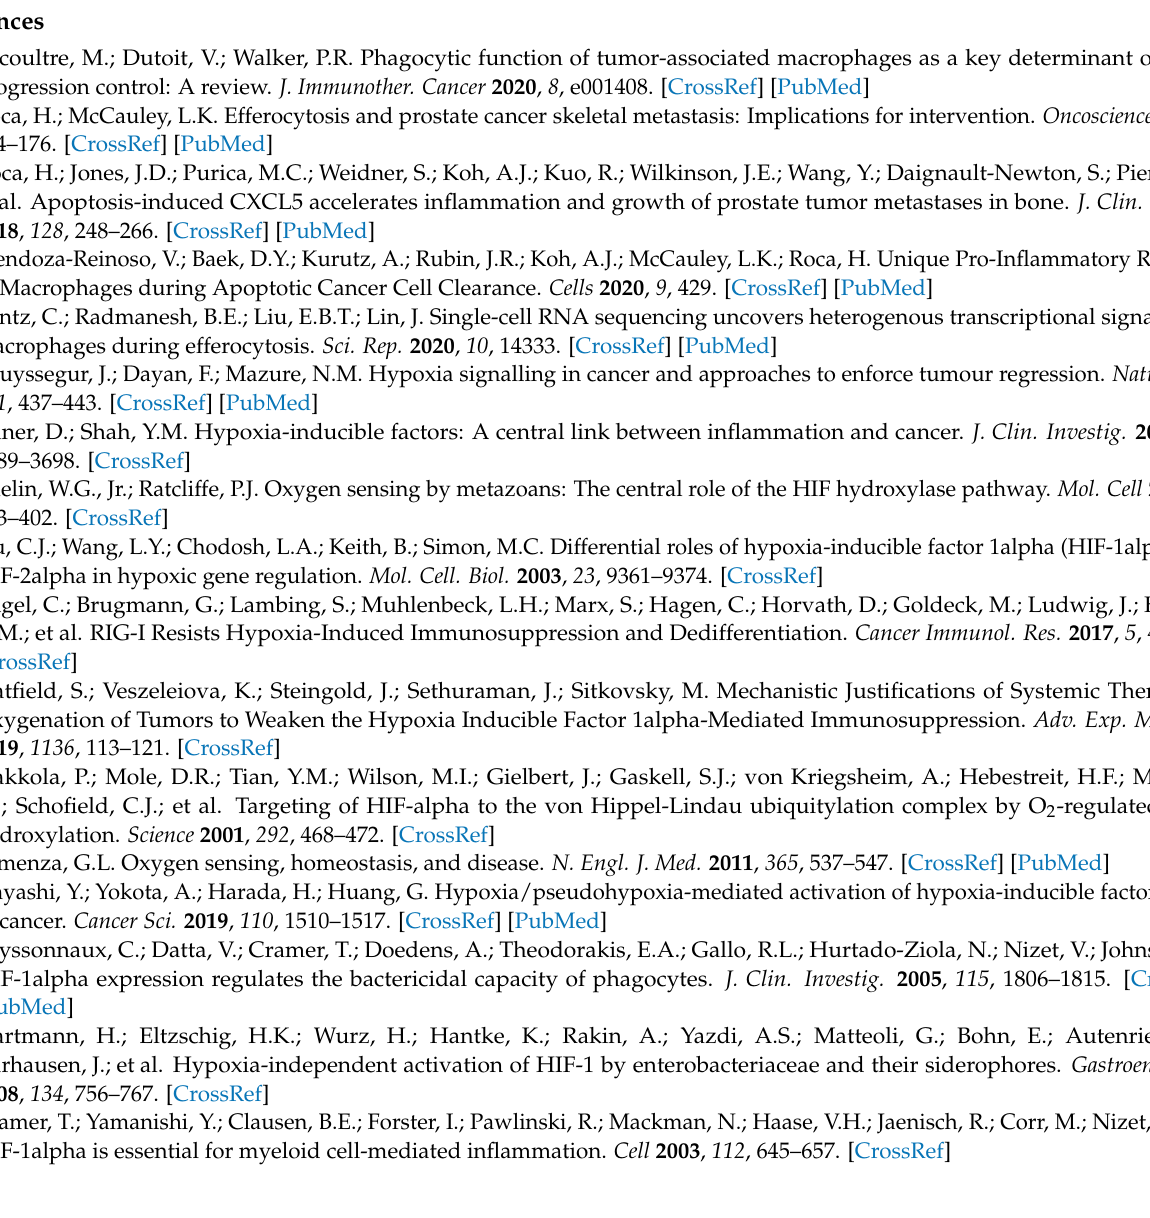
Figure A12. p-STAT3 and HIF-1 α protein expression in MIF treated BM macrophages. BM macrophages (M Φ ) were isolated from 4 wk old C57BL/6J mice and treated with 200 ng/mL recombinant MIF for 2 h (protein analysis) and 8 h (mRNA analysis). ( A ) Western blot analysis of cell lysates from MIF and vehicle treated BM macrophages using p-STAT3 antibody ( n = 3). ( B ) Western blot analysis of cell lysates from MIF and vehicle treated BM macrophages using HIF-1 α antibody ( n = 3). ( C ) mRNAs from MIF and vehicle treated BM macrophages were analyzed by RT-qPCR using Hif1a and Mif probes ( n = 6). Plotted data are shown as mean ± SEM. * p < 0.05, *** p < 0.001, ns = not significant (unpaired t -test).